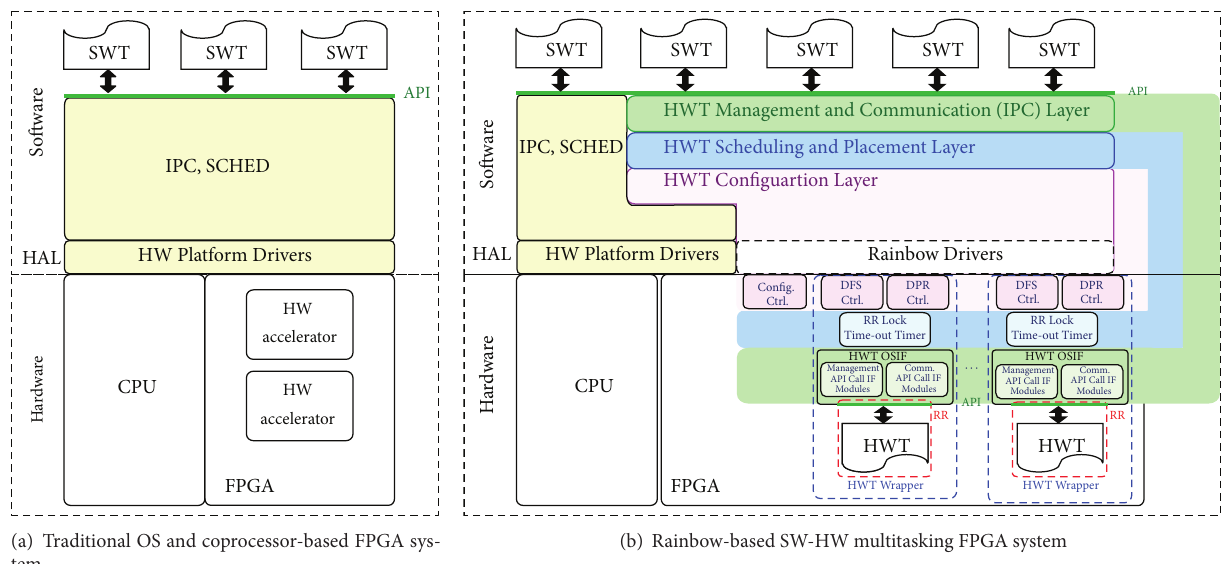
Figure 1: OS architecture model: Traditional versus